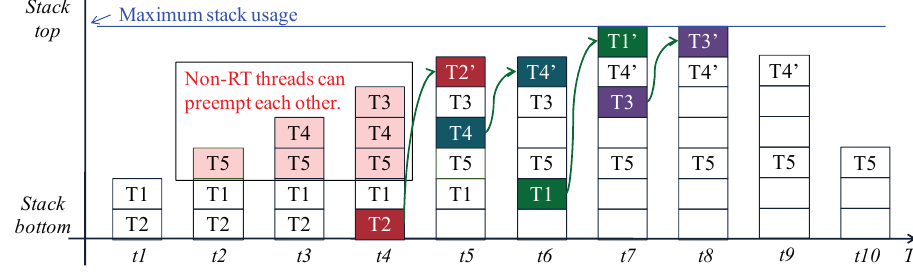
Figure 12. The thread scheduling process and the maximum stack usage in LiveOS before the hybrid scheduling mechanism is implemented.